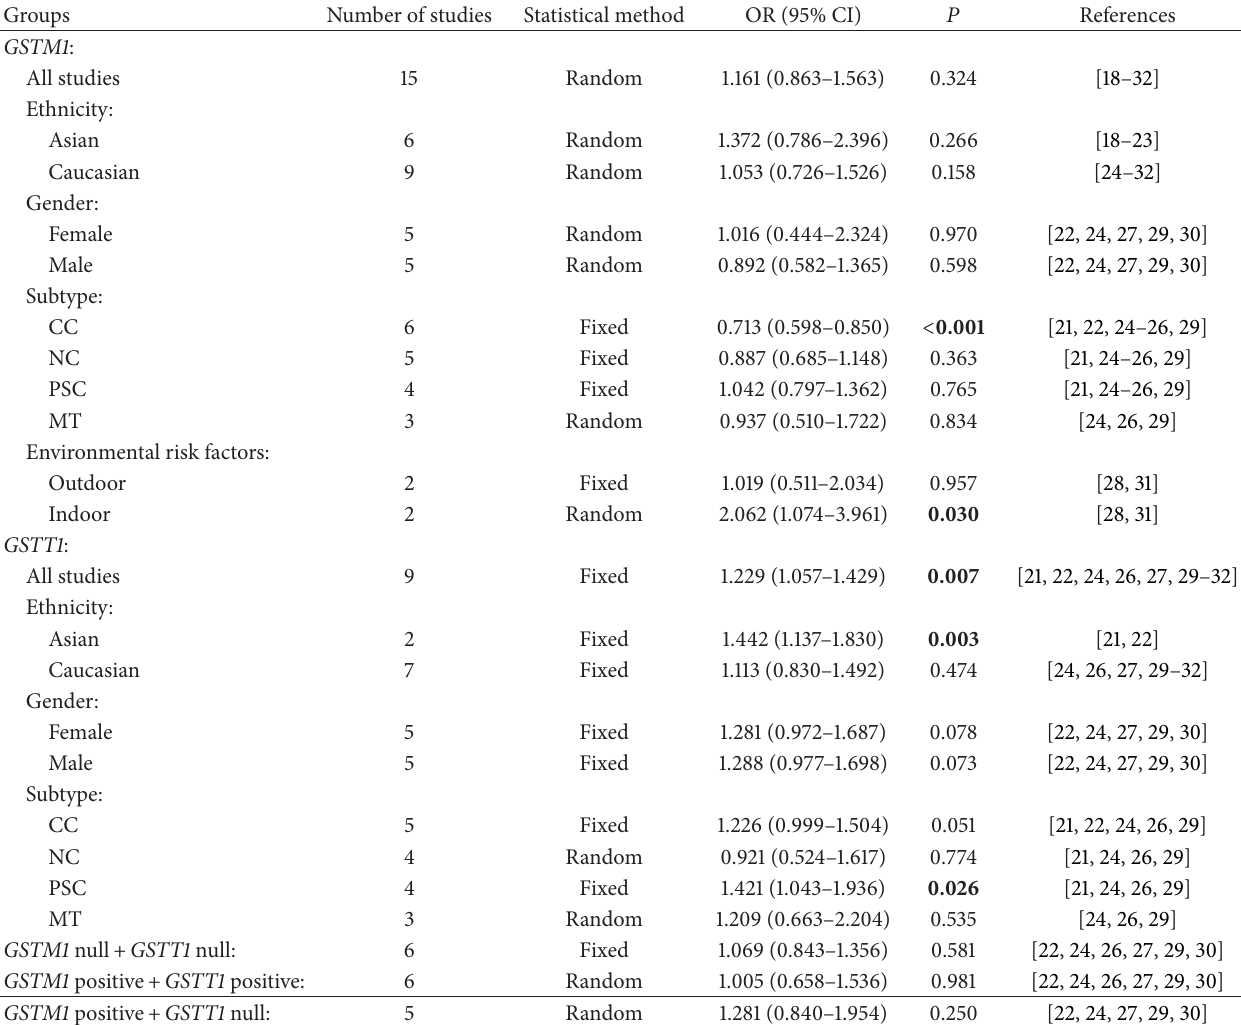
Table 2: Subgroup analysis of the association between GSTM1 and GSTT1 polymorphisms and the risk of age-related cataract.